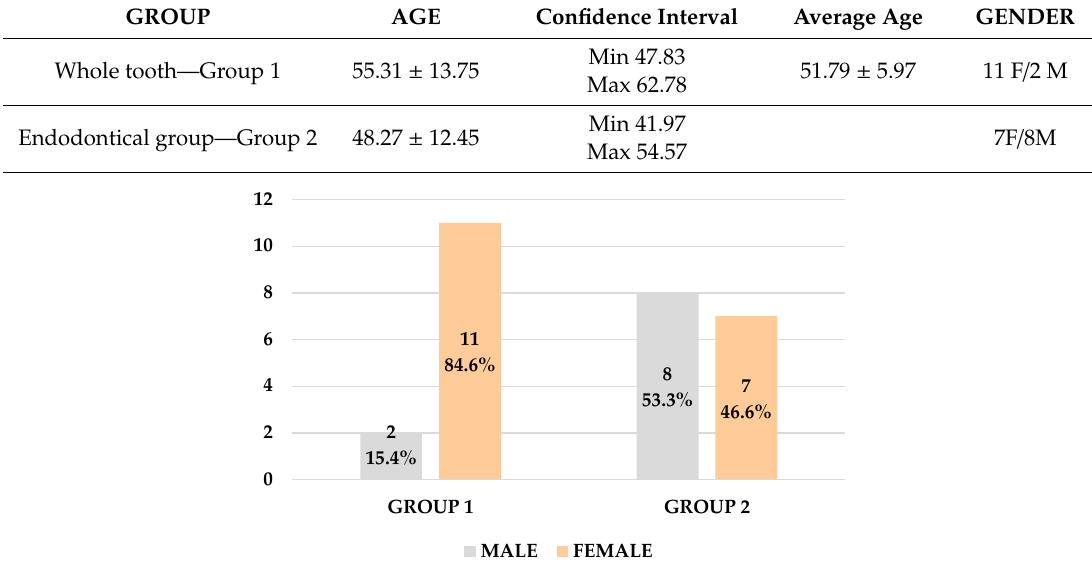
Table 1. Demographic analysis of patients.